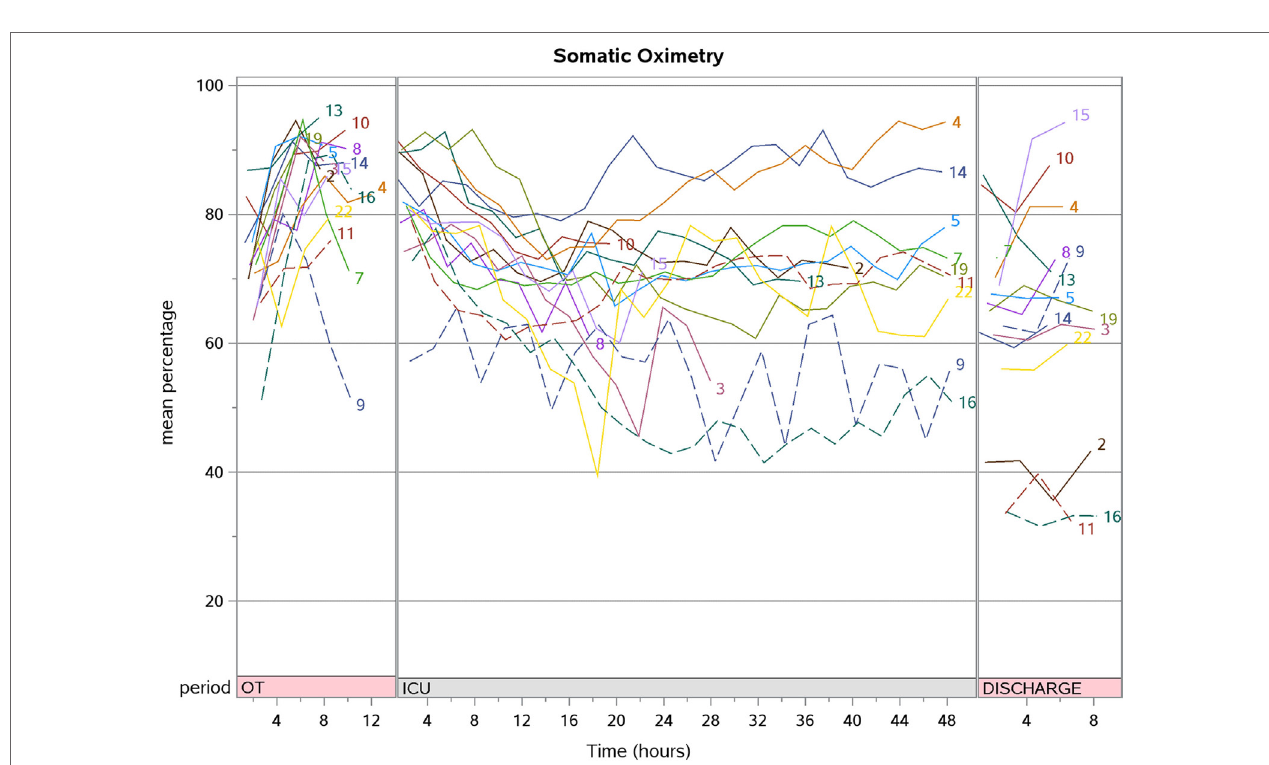
FigUre 3 | The aggregate somatic oximetry trend for patients who underwent corrective surgery ( N =